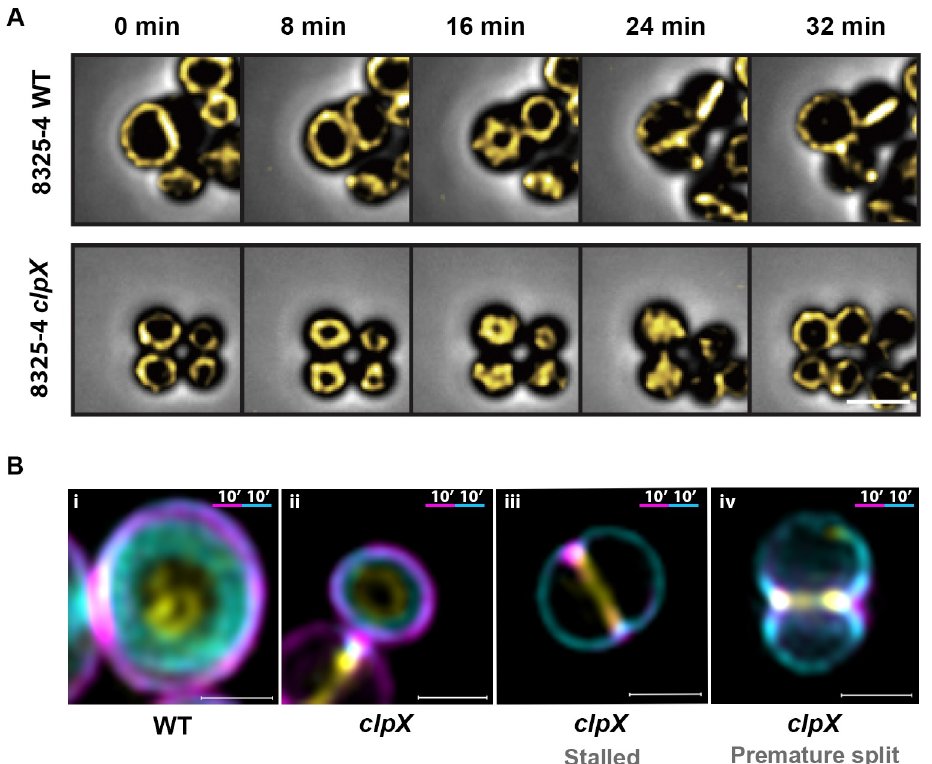
Fig 6. FtsZ localization and Z-ring dynamics appear similar in S . aureus wild-type and clpX mutant cells. FtsZ localization and dynamics were analyzed in S . aureus wild-type and clpX mutant expressing an eYFP-tagged derivative of FtsZ from an IPTG-inducible promoter. ( A ) Still images from time-lapse fluorescence microscopy showing FtsZ- eYFP dynamics in S . aureus wild type and clpX cells growing on a semi-solid matrix in the presence of 100 uM IPTG at 30˚C; (S2 Movie). Images are shown as overlay of phase contrast and the YFP signal, scale bar 1 μ m. ( B ) The FtsZ- eYFP signal localizes ahead of the site of active PG synthesis: localization of FtsZ relative to PG synthesis was analyzed by sequentially labeling S . aureus wild-type and clpX cells growing in TSB + 50 uM IPTG at 30˚C with TADA (red, but displayed in magenta) for 10 minutes followed by washing and labeling with HADA (blue, but displayed in cyan) for 10 min prior to SR-SIM imaging. (i-iv) Examples of cells that started septum synthesis in the first period of labeling: wild-type cell ( i ); clpX cell with normal progression of PG synthesis ( ii ); clpX cell with stalled septum synthesis (HADA-signal localizes at the peripheral cell wall) ( iii ); clpX cell displaying premature split ( iv ). Overview images can be found in S6 Fig. Scale bars 0.5 μ m.